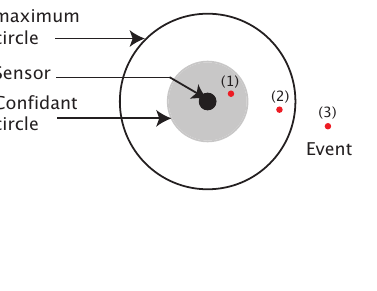
Figure 1. Sensor detection